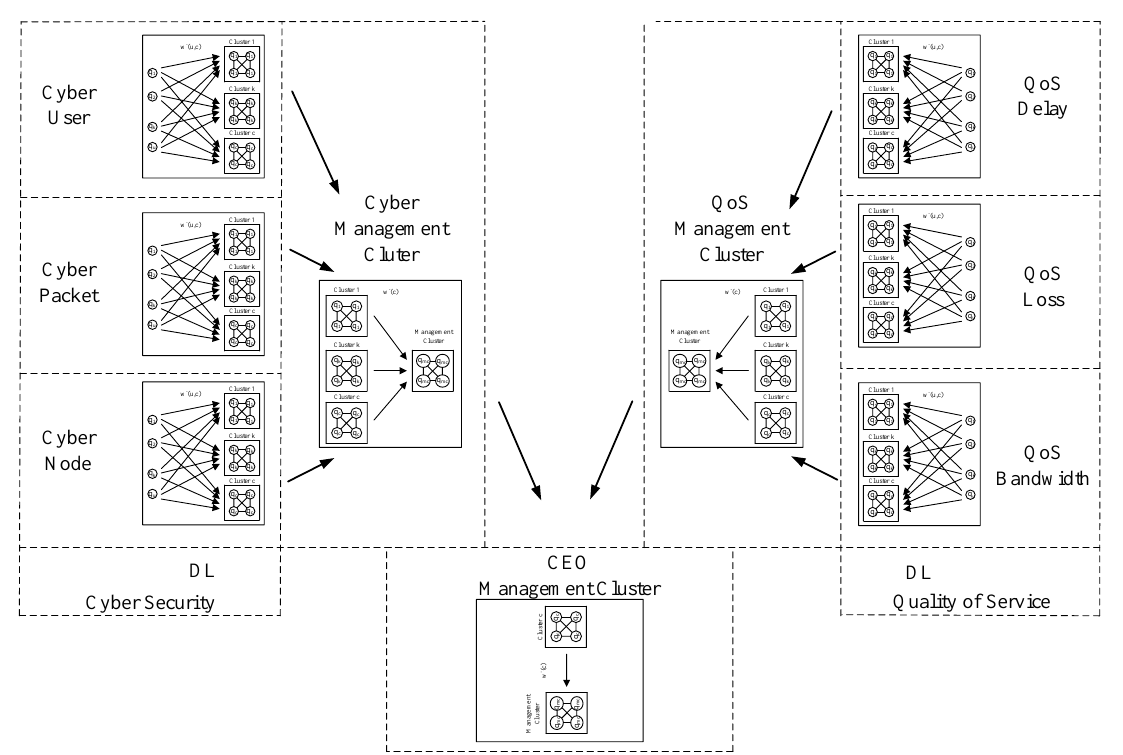
Figure A1. Deep Learning Cluster Structures for Management Decisions — Neural Schematic.